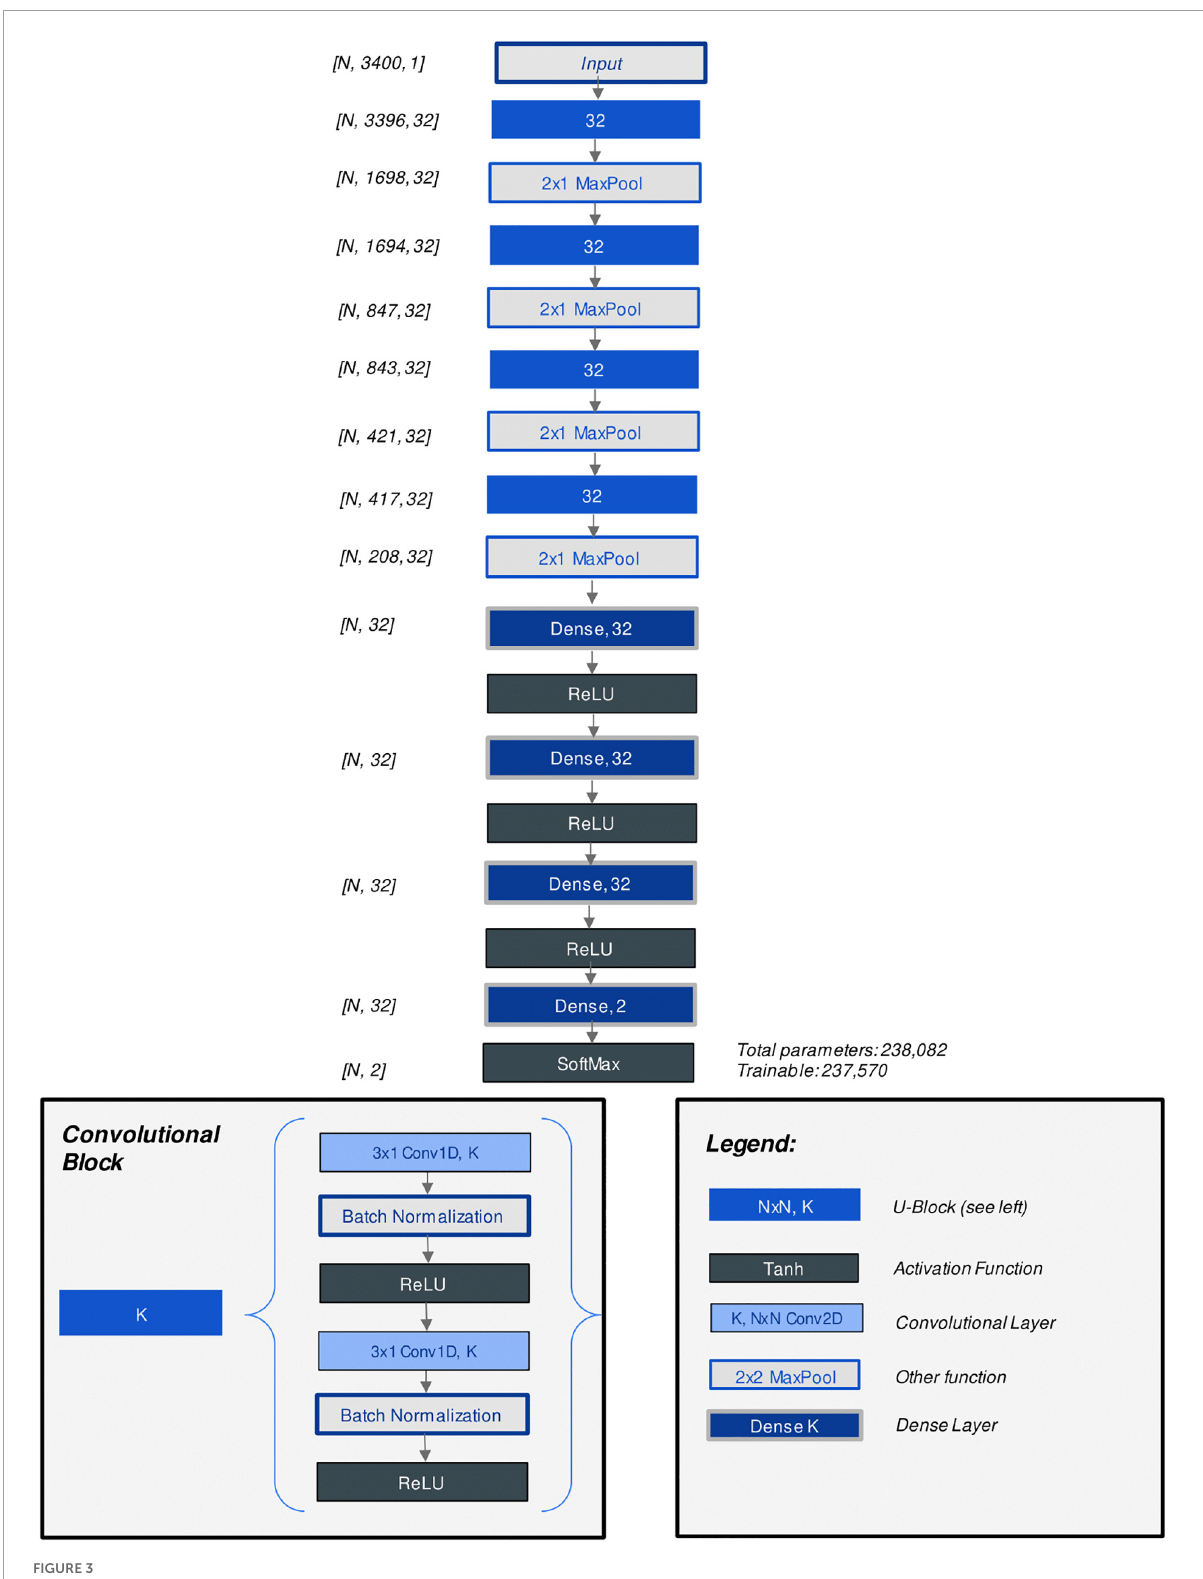
FIGURE3 Diagram of custom CNN model